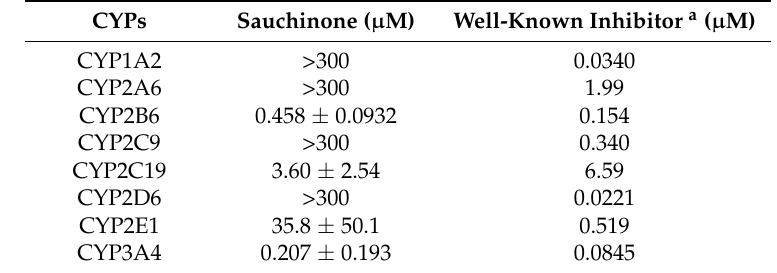
Table 1. IC 50 ( µ M) values of sauchinone and each well-known reversible inhibitor on respective CYP activity in